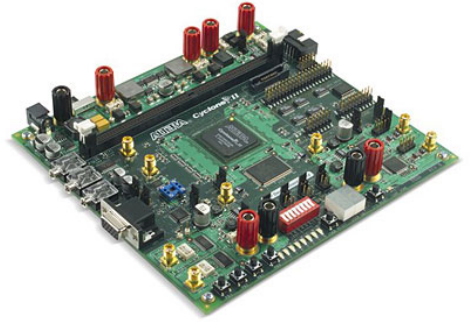
Figure 10. The DSP Development Kit, Cyclone II Edition